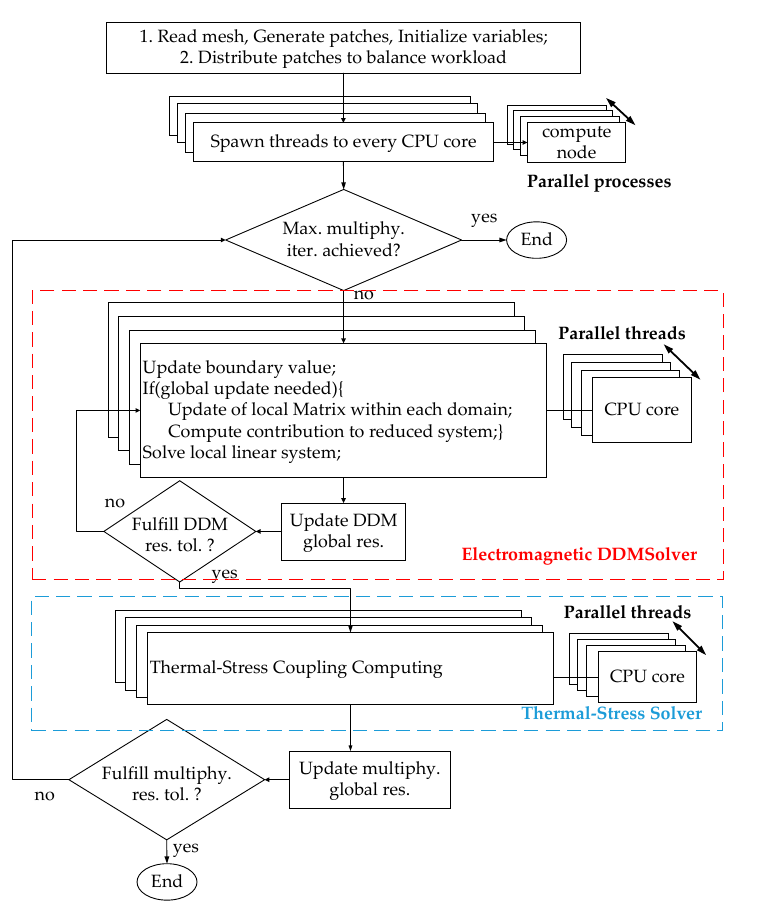
Figure 2. Proposed parallel multiphysics simulation algorithm integrated with JAUMIN (J Parallel Adaptive Unstructured Mesh Applications Infrastructure).